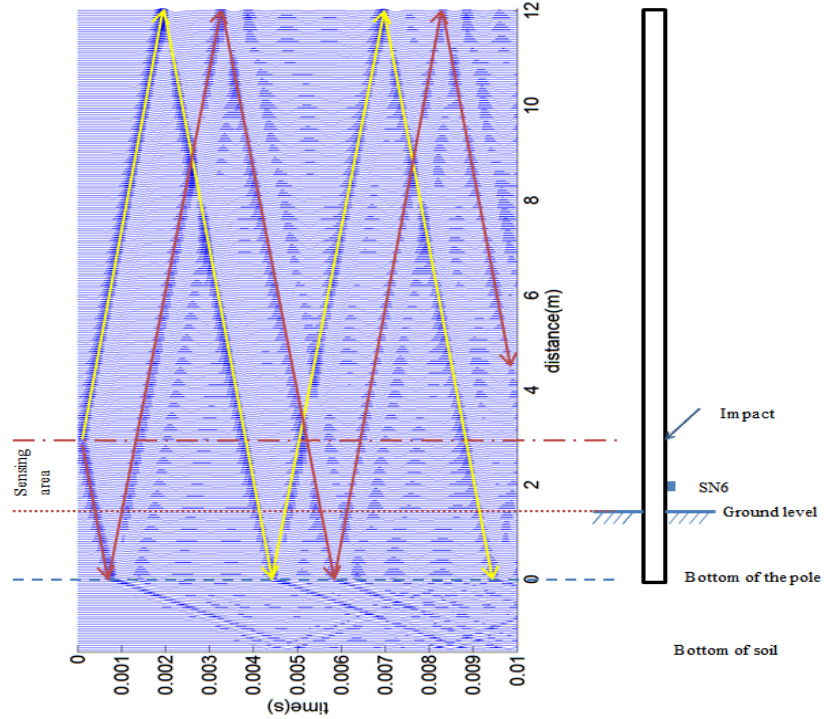
Figure 22. Wave trace in 12 m wood pole and soil.